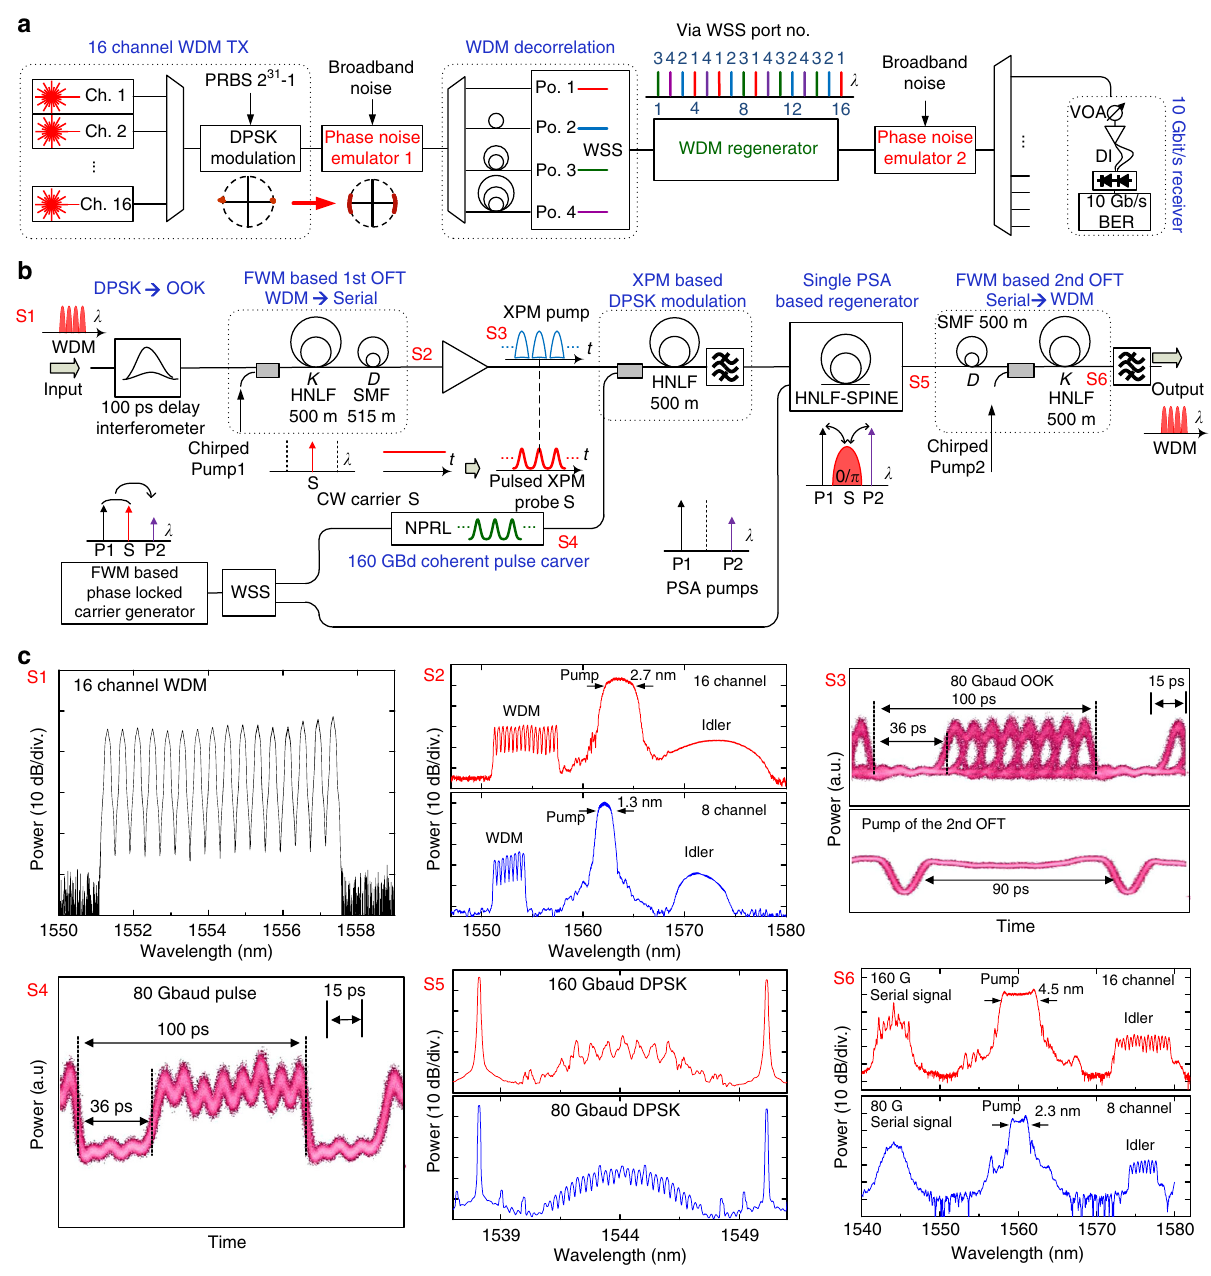
Fig. 5 Experimental demonstration of simultaneous regeneration of 8 and 16 WDM DPSK channels. a Experimental setup of 8× and 16× 10 Gbit/s DPSK WDM regeneration. At the transmitter: 8- or 16-CW carriers are generated by individual CW lasers, and are DPSK modulated by in a MZM. The obtained WDM channels are data decorrelated in a 4-path decorrelator, and are then sent to the optical WDM regenerator. Phase noise is added using a phase modulator driven by broadband electrical noise. At the receiver: after WDM demultiplexing, the regenerated WDM channels are received by a pre- ampli fi ed DPSK receiver including a DI and balanced photo-detection. b WDM regenerator, a 100-ps DI is used convert all WDM DPSK channels (S1) to OOK signals, which are then converted to a 80-or 160-GBd serial signal by the fi rst OFT (S2). The obtained serial OOK signal (upper S3) is coupled into the HNLF as an XPM pump to optically phase modulate the pulsed XPM probe (S4). The pulsed XPM probe is generated from carving the CW carrier S using a NPRL. A single PSA (S5) is employed for phase regeneration of the obtained serial DPSK signal. Finally, the regenerated serial signal is converted back to WDM signals by the second OFT (S6) using a 90-ps pump pulse (lower S3). c Spectrum of the input WDM channels (S1), 1st OFT output spectrum (S2), waveform of the 80 GBd OOK signal (upper S3), waveform of the 2nd OFT pump (lower S3), waveform of the coherent pulse (S4), output spectrum of the PSA (S5), 2nd OFT output spectrum